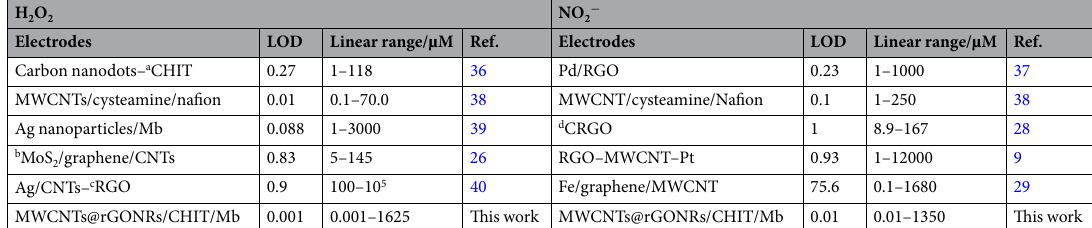
Table 1. Comparison of electroanalytical parameters of H 2 O 2 obtained at MWCNTs@rGONRs/CHIT/ Mb bioelectrode with previously reported electrodes a CHIT = Chitosan, b MoS 2 = Molybdenum disulfide, c RGO = Reduced graphene oxide, d CRGO = Chemically reduced graphene